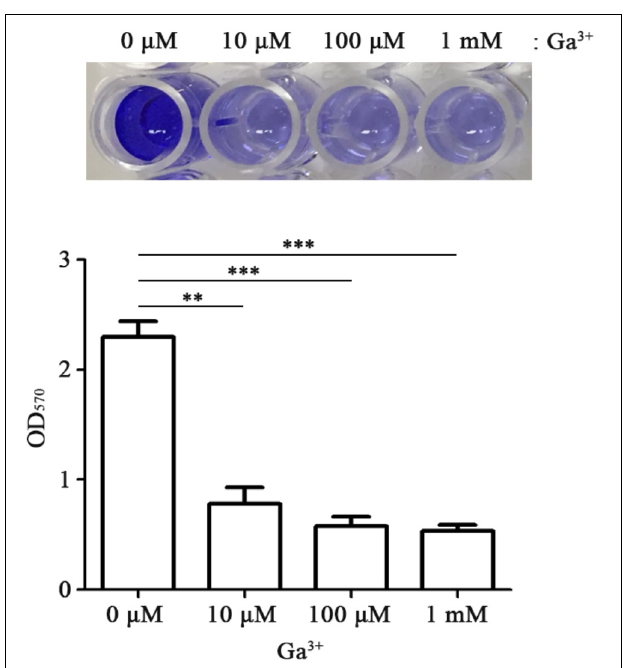
gallium had antimicrobial activity against EHEC FORC_035.